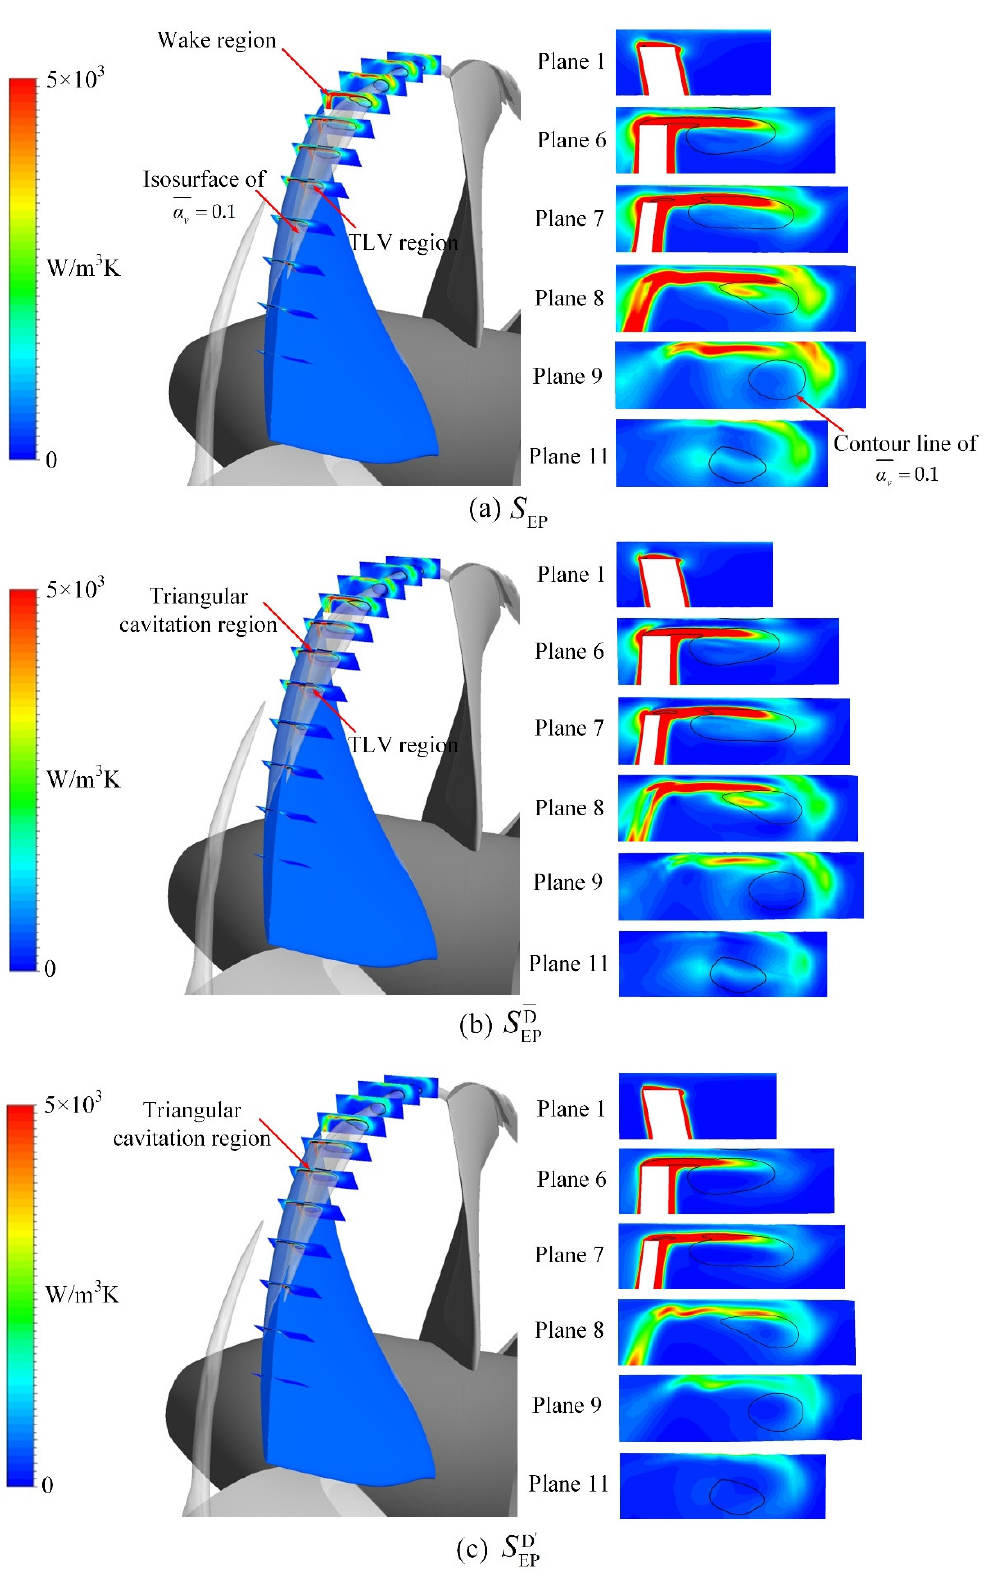
Figure 12. Entropy production-rate distributions near the clearance. ( a ) Total entropy-production rate; ( b ) entropy-production rate caused by time-averaged velocity; ( c ) entropy-production rate caused by fluctuating velocity.